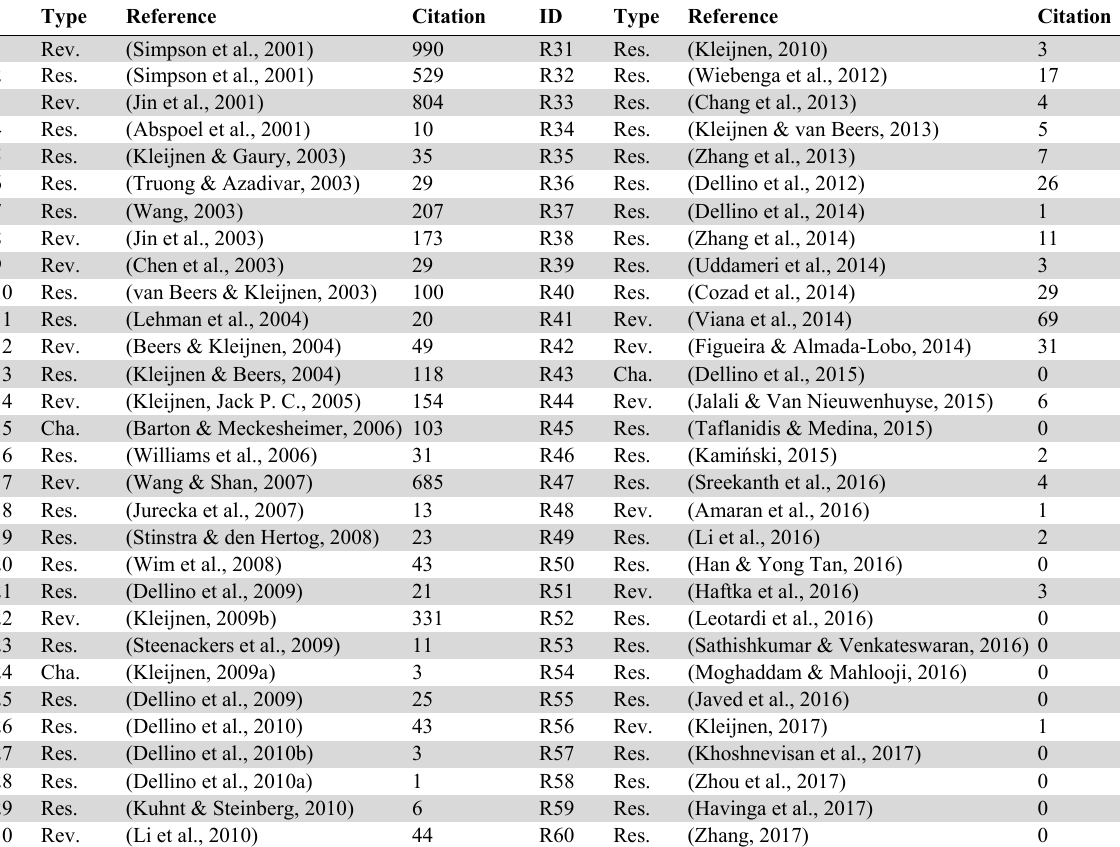
Identifiers of articles (“Rev.” means review paper, “Res.” means research paper, and “Cha.” means